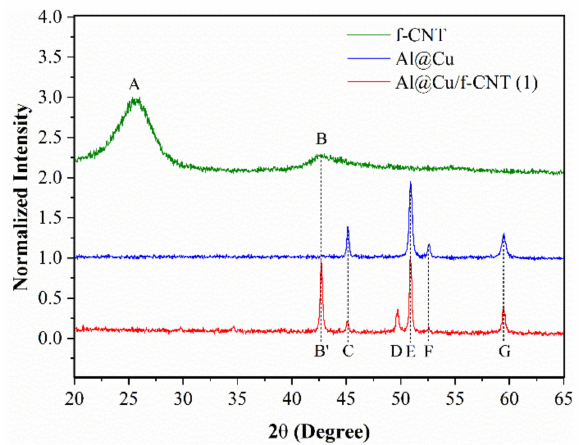
Figure 3. XRD patterns of f-CNT, Al@Cu and Al@Cu/f-CNT (1)